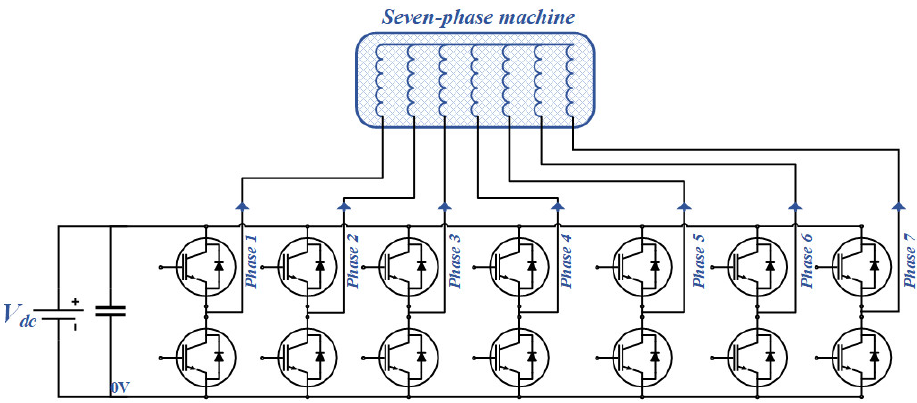
Figure 27. Two-level converter topology for a seven-phase voltage source drive.